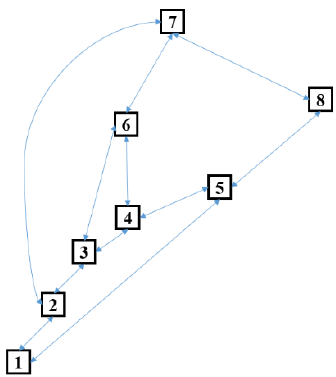
Figure 8. Transportation network of case example, where the numbered squares are the zones, and the arrows indicated the travel networks between the zones.